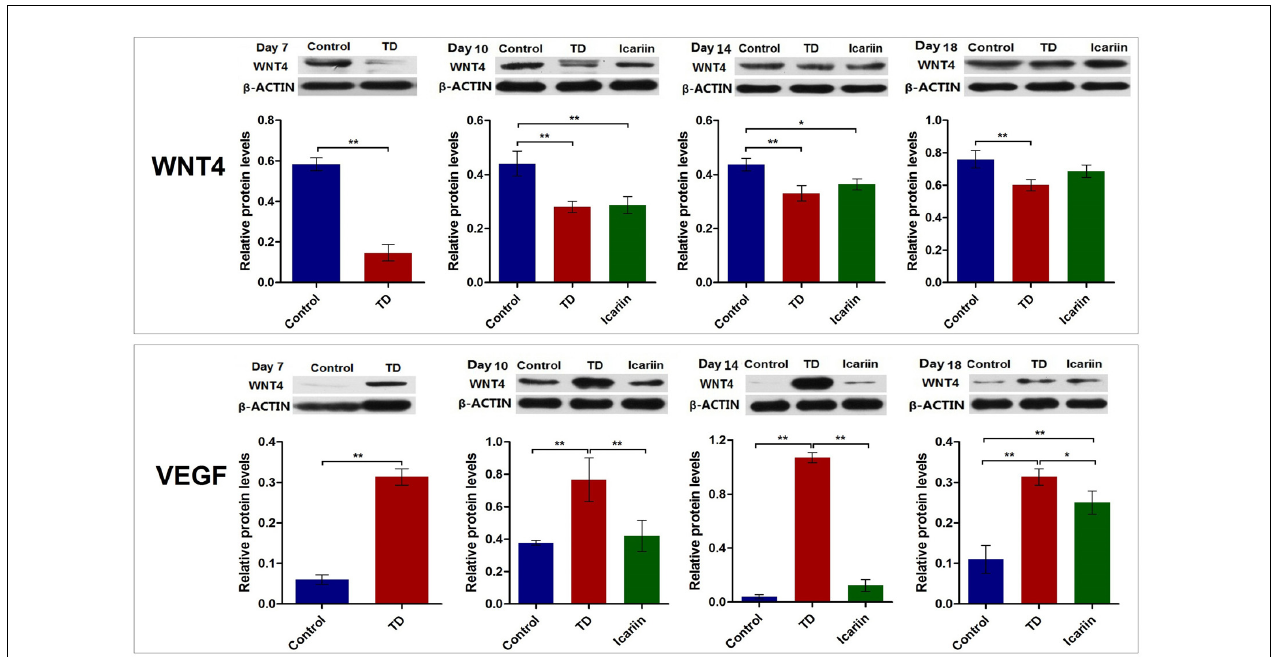
FIGURE 10 | The WNT4 and VEGF protein level was analyzed in tibial growth in control, TD, and icariin group chickens at 7, 10, 14, and 18 days. Data is expressed in arbitrary units as means ± SEM. ∗ P < 0.05, ∗∗ P <